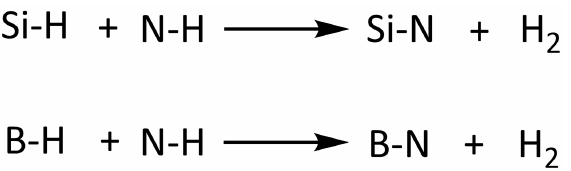
Scheme 2. Cross ‐ linking reaction of Si–H and B–H with N–H. Scheme 2. Cross-linking reaction of Si–H and B–H with